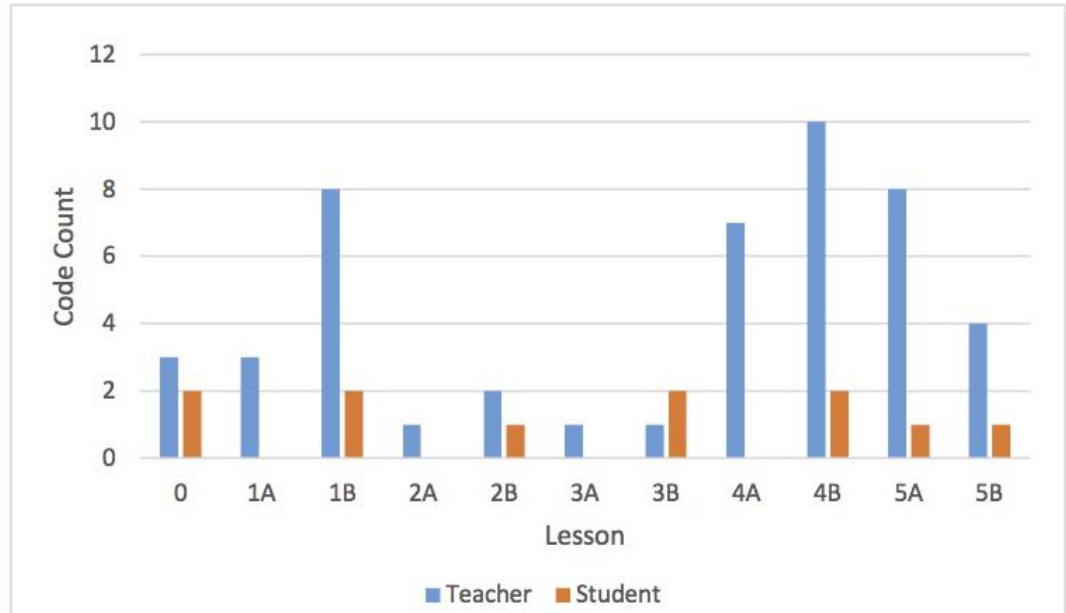
Figure 5. Instances coded as using curriculum-specific engineering language